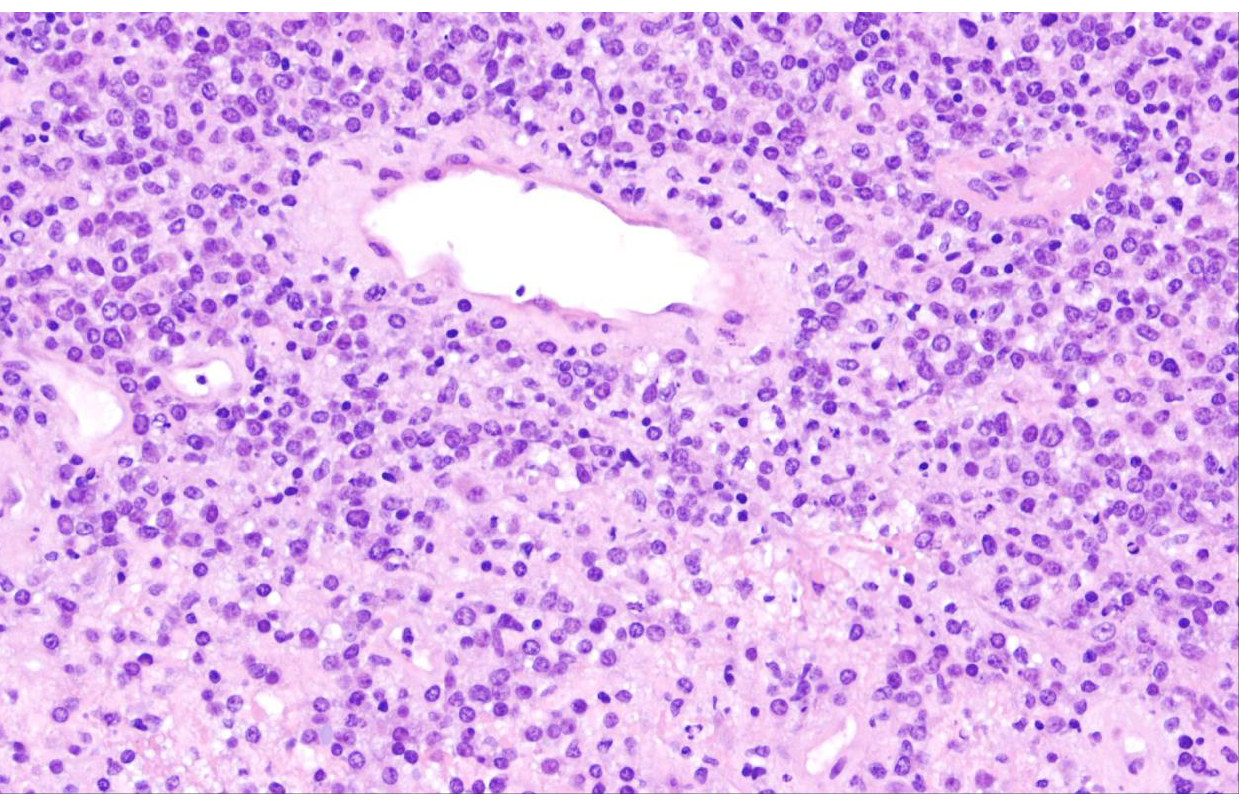
Figure 11. Primary large B-cell lymphomas (LBCL) of immune-privileged sites (H&E ×200). This is an example of a primary central nervous system LBCL with diffuse and perivascular infiltration patterns.